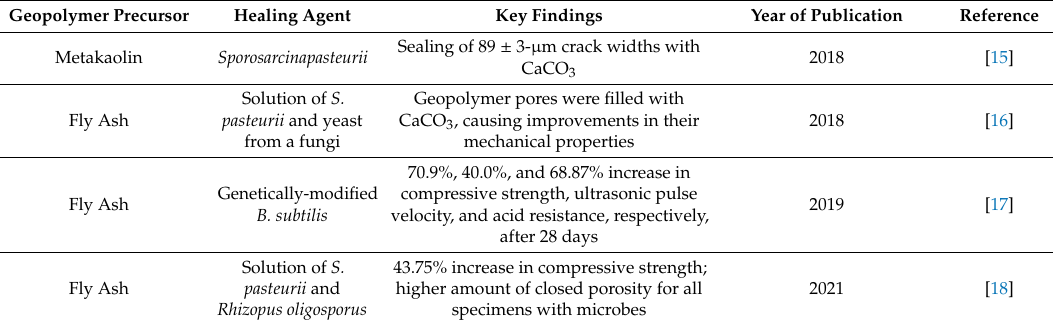
Table 1. Related studies on microbial applications on